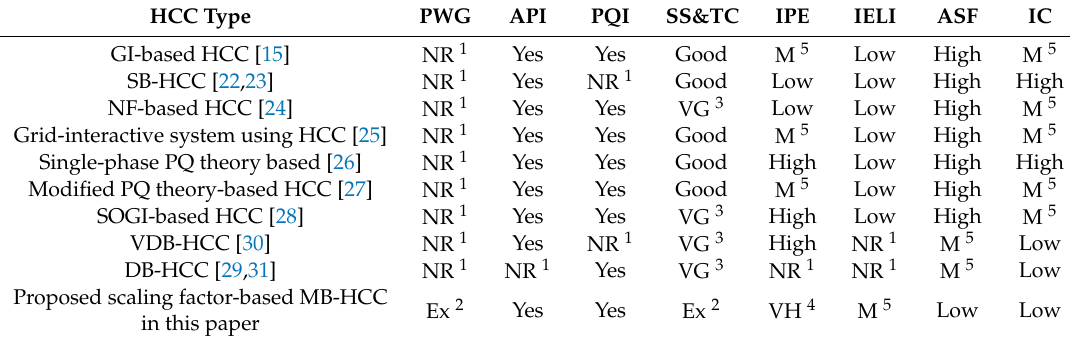
Table 1. Comparison of previous hysteresis current control (HCC)-based single-phase grid-tied inverter literature. HCC